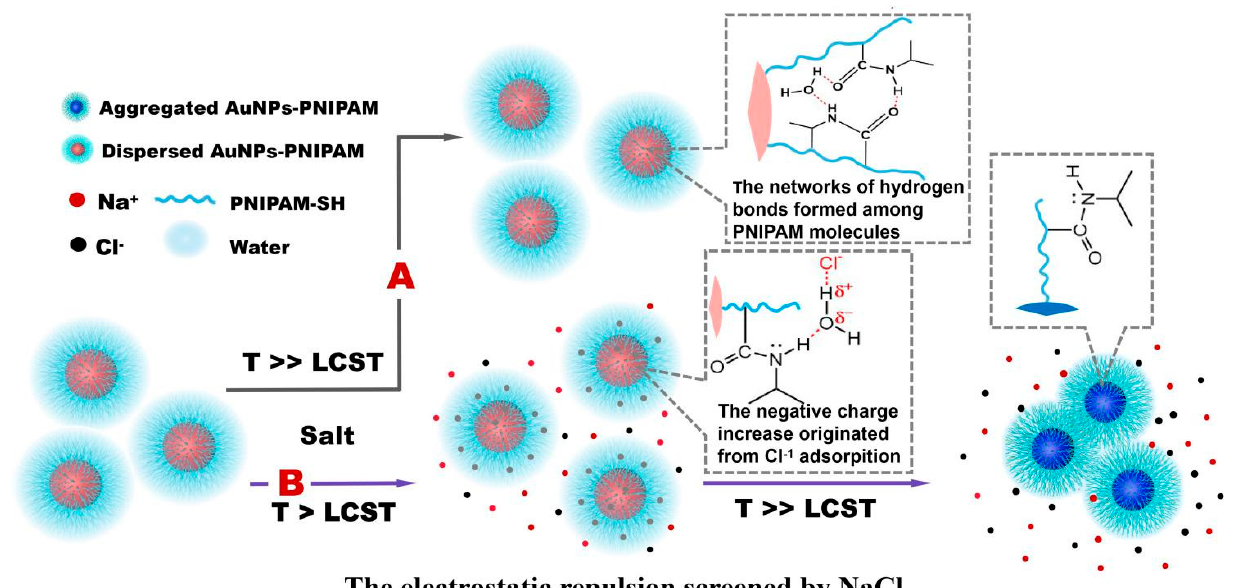
Figure 6. The possible mechanisms on the dispersive behavior of AuNPs-PNIPAM with change in temperature. ( A ) AuNPs-PNIPAM in absence of salt medium. The networks of hydrogen bonds formed among PNIPAM molecules restraining the thermo-sensitivity conformational change of PNIPAM; ( B ) AuNPs-PNIPAM in the presence of salt medium. The dispersive behavior of AuNPs-PNIPAM affected by the temperature dependent electrostatic interactions (including NaCl electrostatic screening, the negative charge increase due to Cl − 1 adsorption and enhancing dehydration of PNIPAM chains due to Cl − 1 polarization).